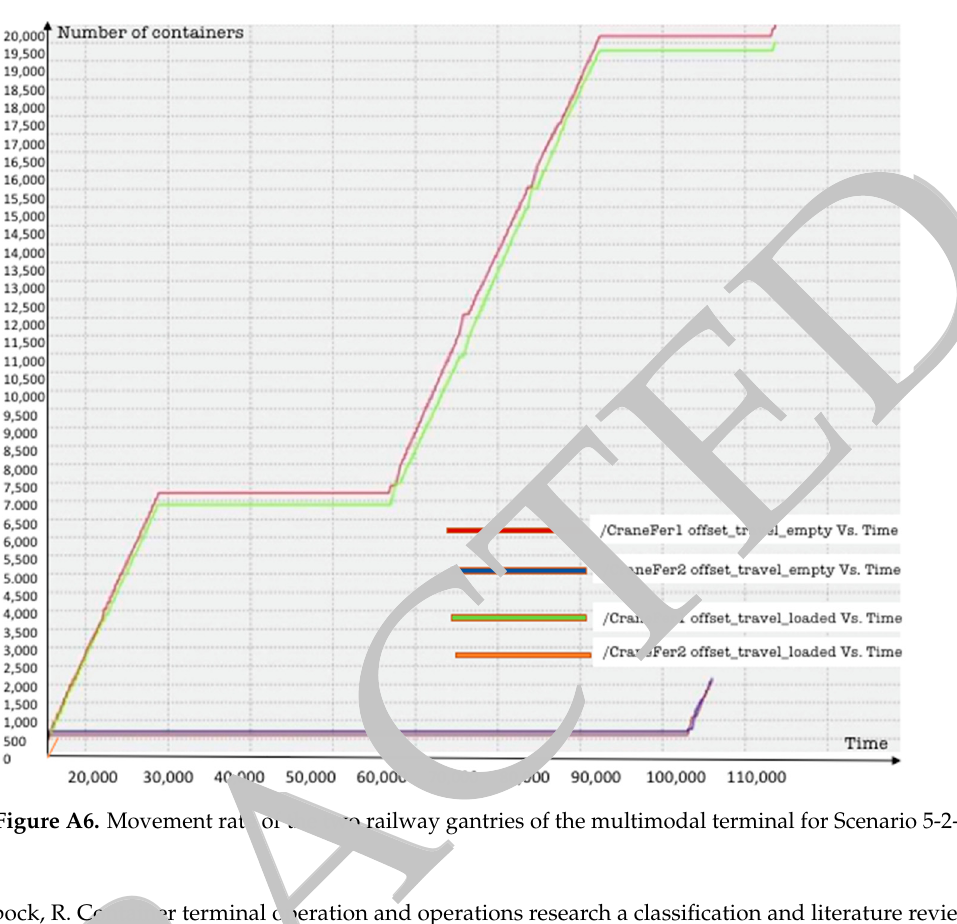
Figure A6. Movement rate of the two railway gantries of the multimodal terminal for Scenario 5.